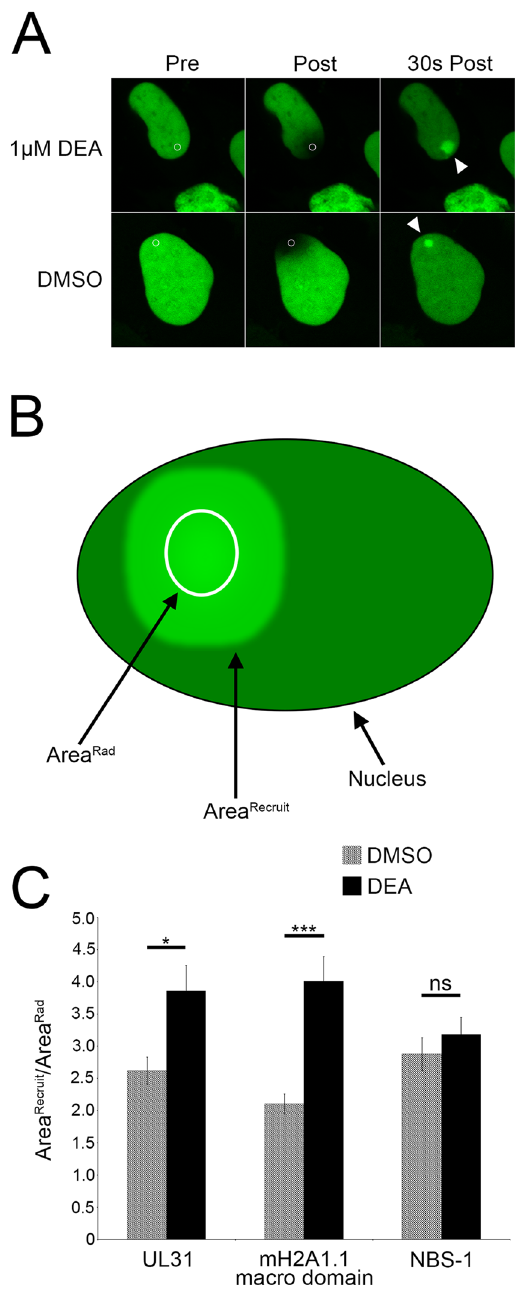
Figure 10. Inhibition of PARG results in enhanced recruitment EGFP-UL31 to sites of laser microirradiation. ( A ) Cells expressing EGFP-UL31 were treated with 0.1% DMSO (vehicle) or 1 μ M DEA, a PARG inhibitor, two hours prior to imaging. Images of cells were captured immediately before (Pre), immediately after (Post) and 30 seconds after the region within the white circle was microirradiated using a 405 nm laser line. The intensity of radiation and size of the area of irradiation were maintained between all cells irradiated. ( B ) We define the ratio of areas, Area Recruit /Area Rad , as the area of protein recruitment at Δ max (Area Recruit ) divided by the initial area that was microirradiated (Area Rad ). ( C ) Graph of the ratio of areas of UL31, NBS1 and H2A1.1 macro domain in DMSO (vehicle) and 1 µ M DEA treated cells. Area Recruit /Area Rad was calculated for each construct (n ≥ 11) from two independent experiments. Error bars represent standard error of the mean. (ns = not significant, * p < 0.05, *** p <